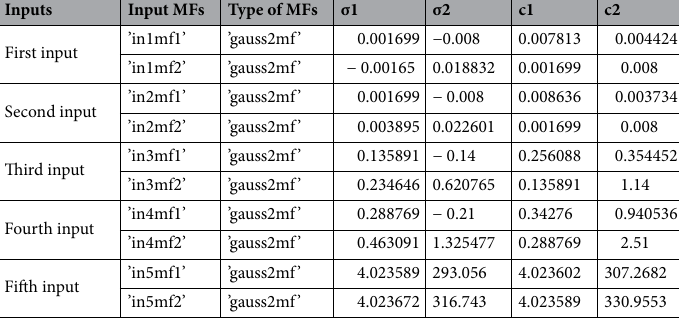
Table 5. The input parameters of the used MF in this